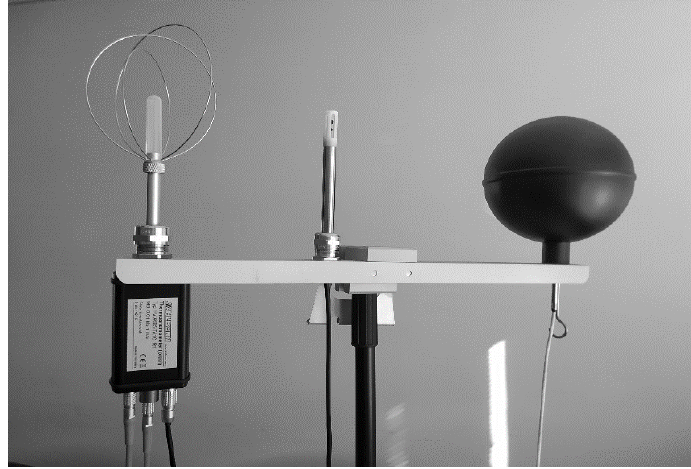
Figure 6. Measuring device consisting of thermal comfort sensors used for a study.